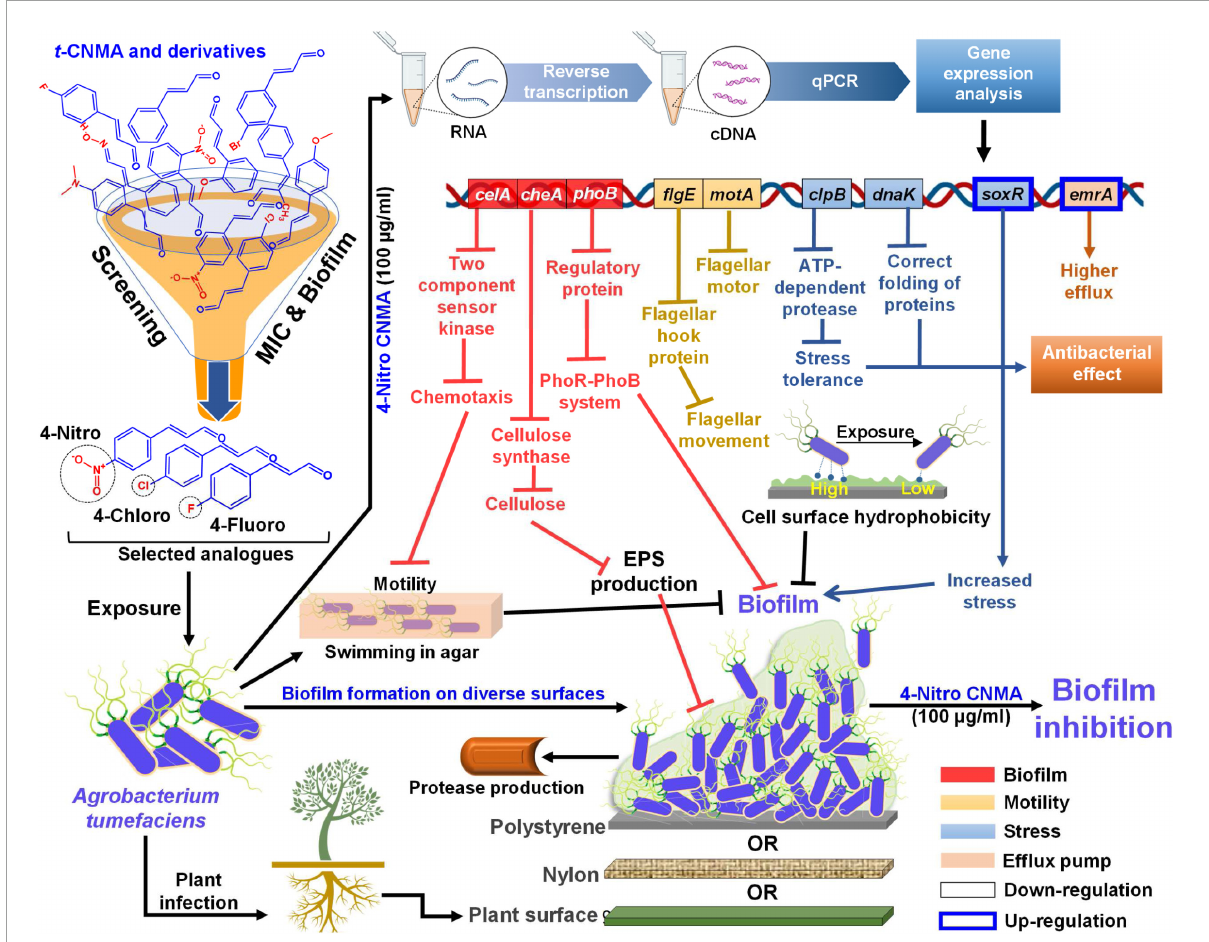
FIGURE9 Mechanistic illustration of A. tumefaciens interaction with t -CNMA and its analogs specifically 4-nitro CNMA after screening based on MIC and biofilm inhibition percentages. A. tumefaciens was able to swim in agar by flagellar machinery, showed cell surface hydrophobicity, showed protease and EPS production, EPS and biofilm on three different surfaces nylon, polystyrene, and plant root (displayed beneath the biofilm). Selected derivatives inhibited these virulence factors and biofilm phenotype. Higher alterations in gene expressions were observed by 4-nitro CNMA than t -CNMA. Different color-coded gene boxes represent specific virulence phenotype (i.e. biofilm, motility, stress, and efflux), solid black bordered boxes show downregulation while blue bordered boxes show upregulation of genes. Arrows in different colors represent different group of genes and flat arrow ends stand for inhibition. cDNA, complimentary DNA; qPCR, quantitative polymerase chain reaction; MIC, minimum inhibitory concentration; EPS,